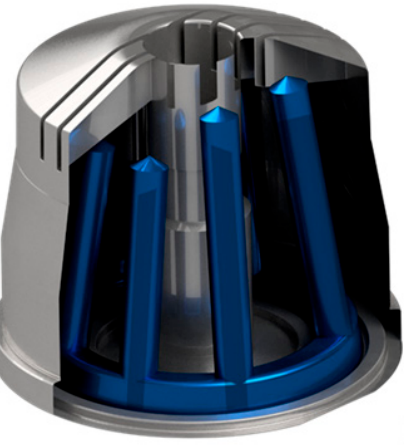
Figure 5. Sectional view of the solid mold core; cooling system consisting of channels with circular cross-sections, divided by pass partition plates. The cooling system consists of eight channels.